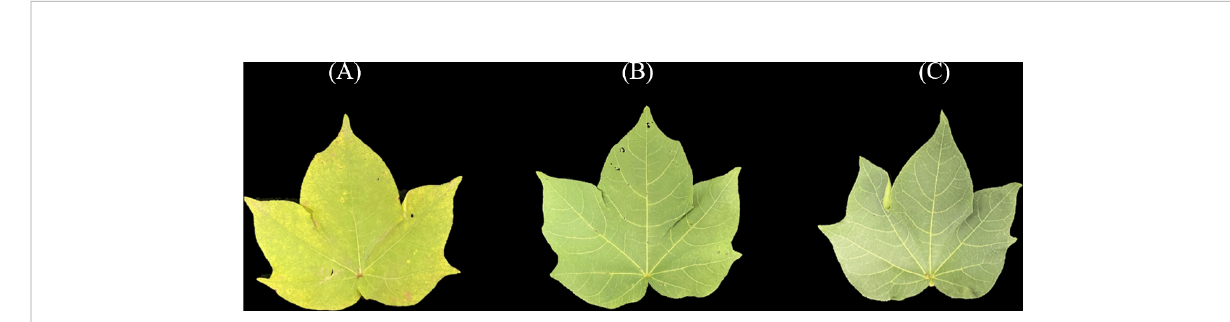
FIGURE 2 Cotton leaves with different LNC levels: (A) low-level LNC, (B) medium-level LNC, (C) high-level LNC.